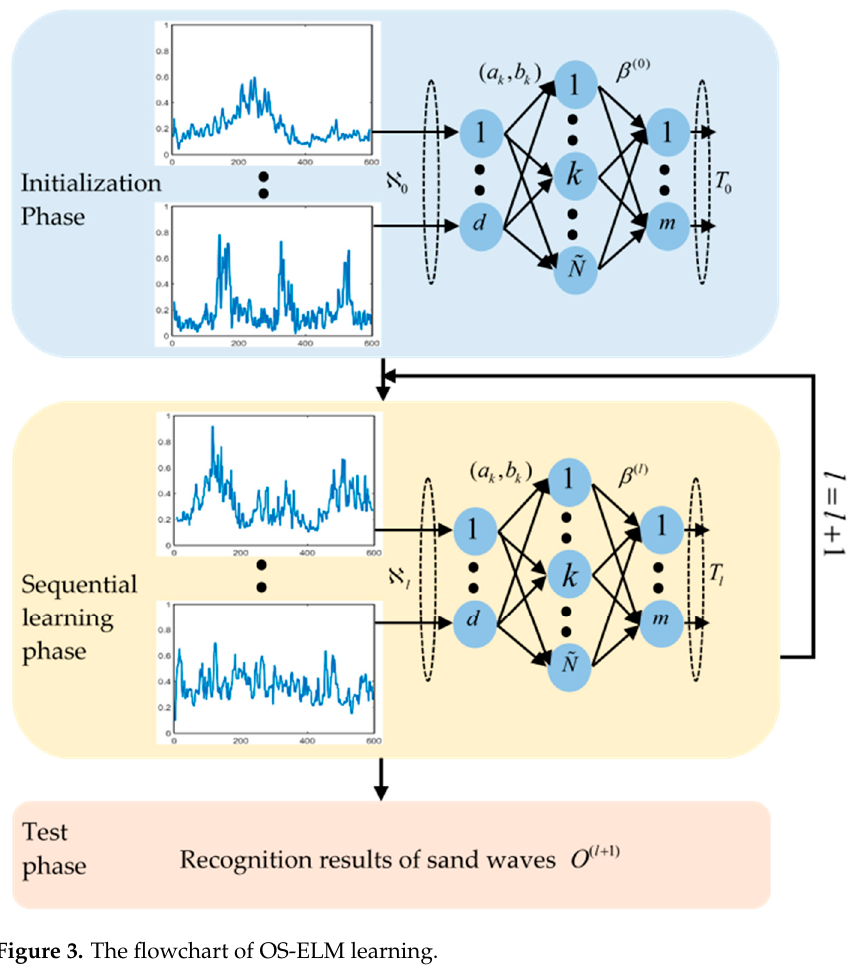
Figure 3. The flowchart of OS-ELM learning.